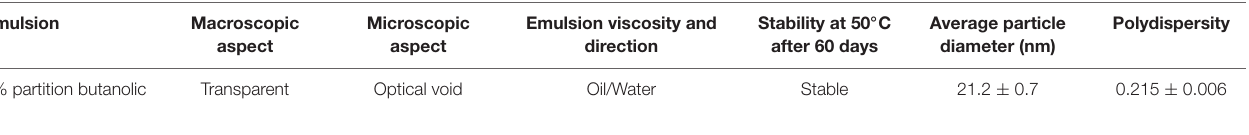
TABLE 1 | Characteristics of the